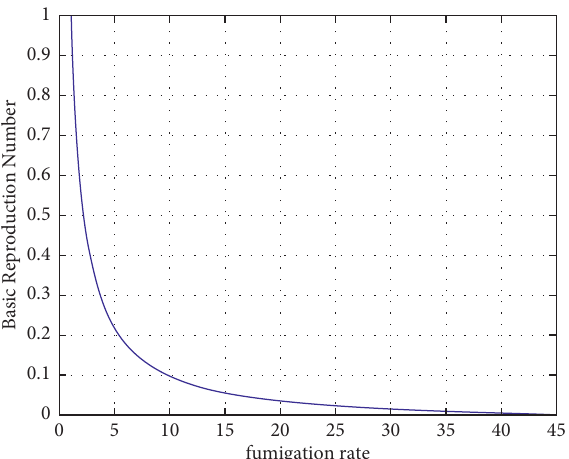
Figure 23: Basic reproduction number with